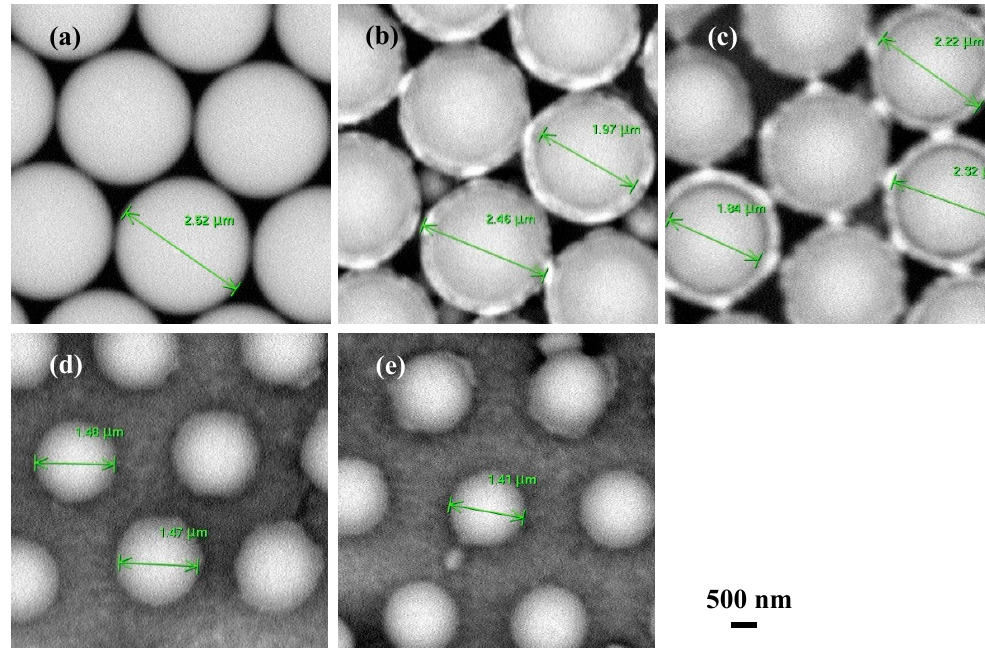
Figure 1. A top view of the SEM images of the aligned silica glass microspheres on silicone rubber after the HF chemical etching for ( a ) 0, ( b ) 15, ( c ) 30, ( d ) 60, and ( e ) 90 s.